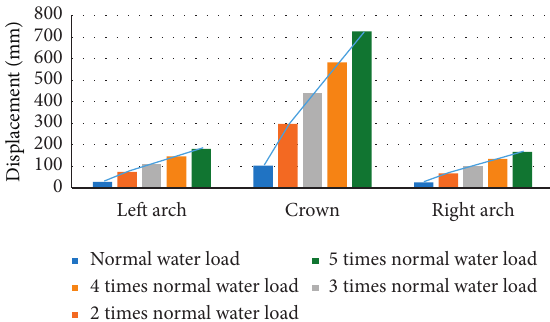
Figure 7: Comparison of the displacement of the arch dam along the river under different load combinations.